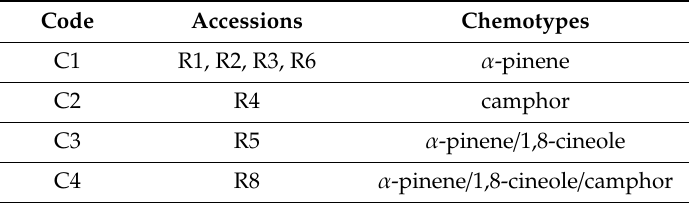
Table 4. Effect of the different EOs on seed germination inhibition and on seedling vigor index of A. retroflexus and L. perenne .